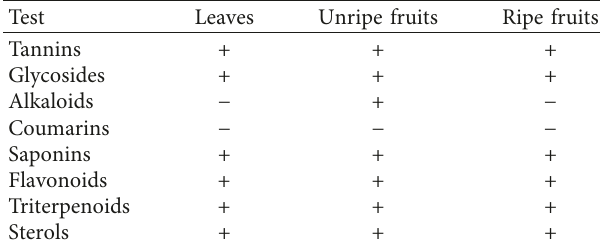
Table 1: Phytochemical constituents of D. erecta